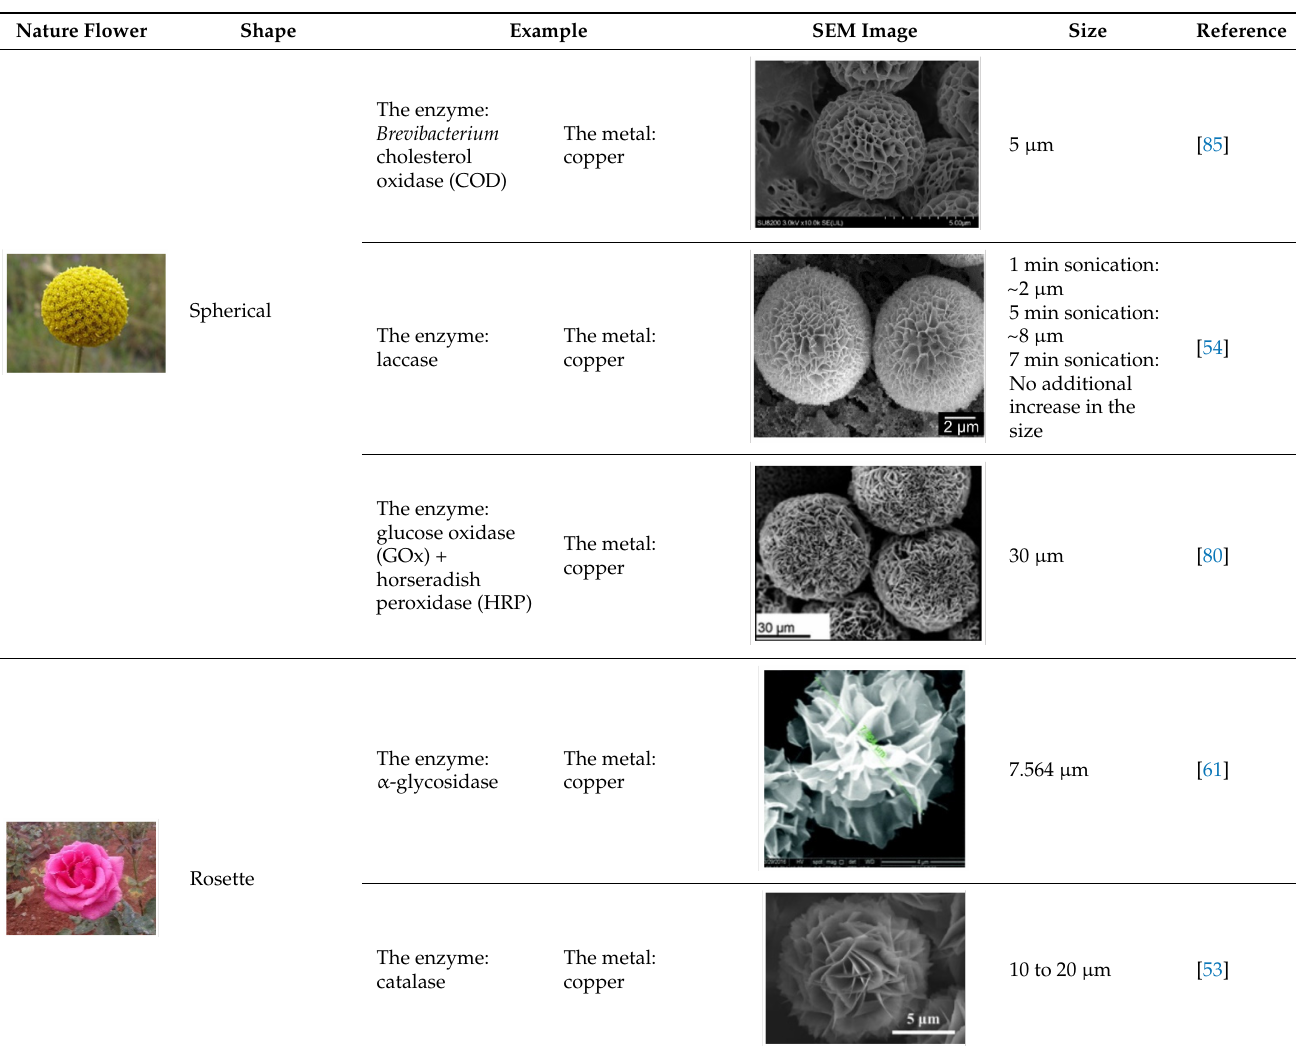
Table 2. Characteristic of hybrid